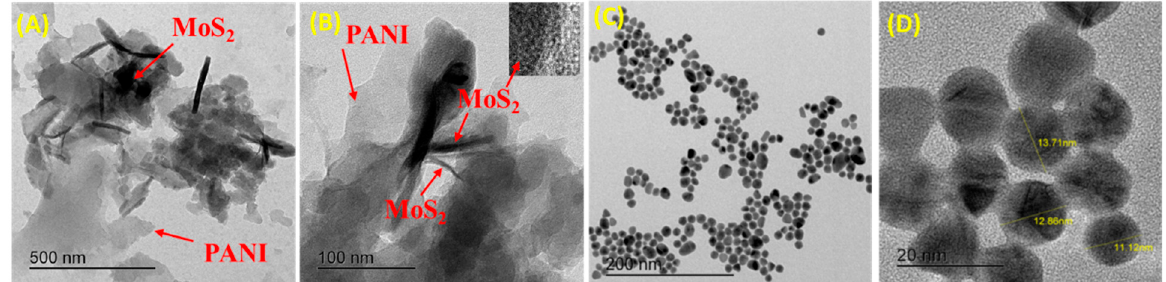
Figure 3. ( A , B ) TEM images of the MoS 2 –PANI composite; ( C , D ) TEM images of AuNPs.